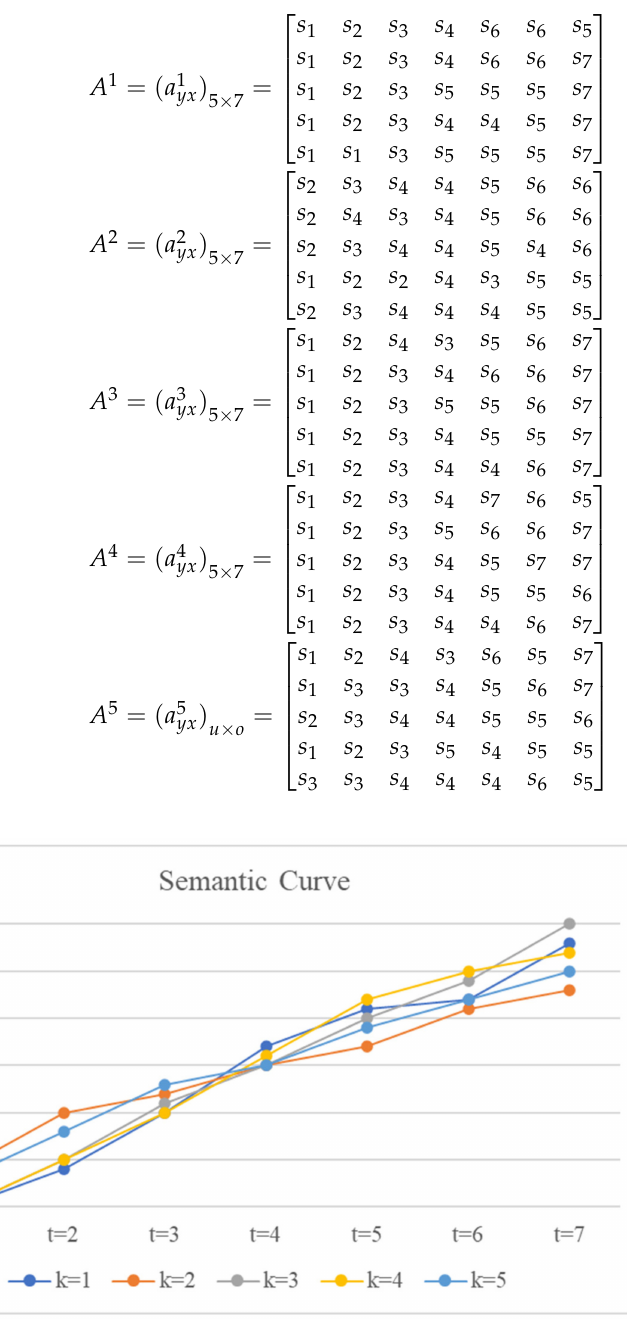
Figure 8. The semantic curves of